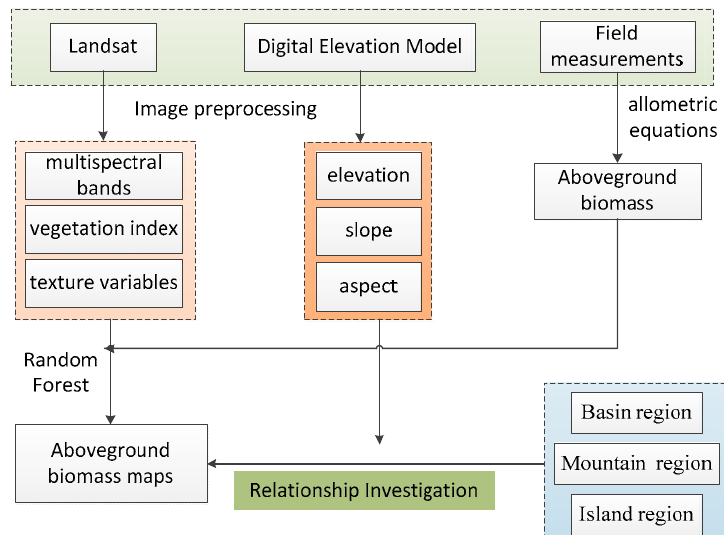
Figure 1. The flowchart of this research.